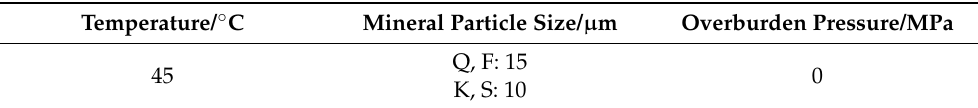
Table 9. Applicable conditions of the morphology prediction